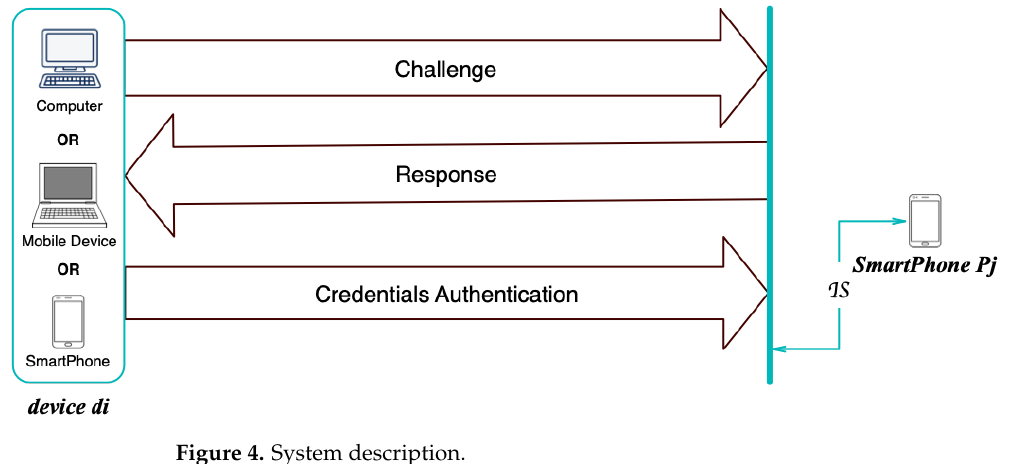
Figure 4. System